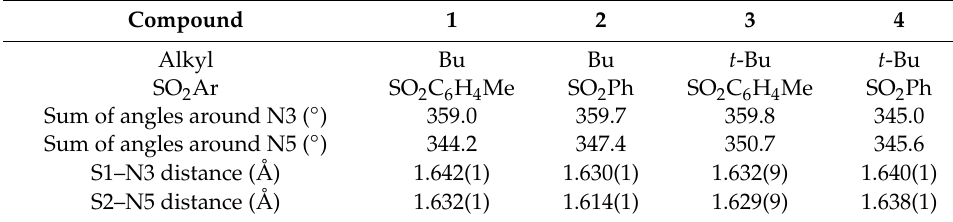
Table 2. Sums of angles at the sulfonamide nitrogen atoms N3 and N5 and S–N distances in 1,3,5-triazinanes 1 – 4 .